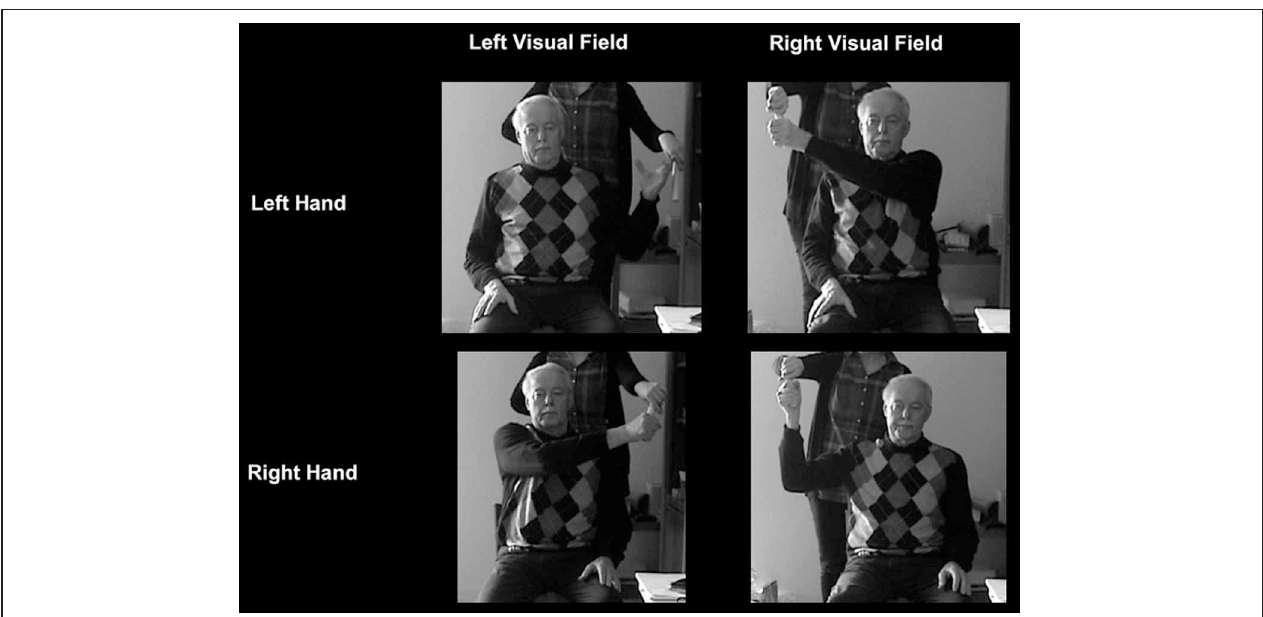
FIGURE 2 | OA patient with a right-hemisphere lesion grasps the pole in the different hand-field combinations during the fixation condition (peripheral grasping).